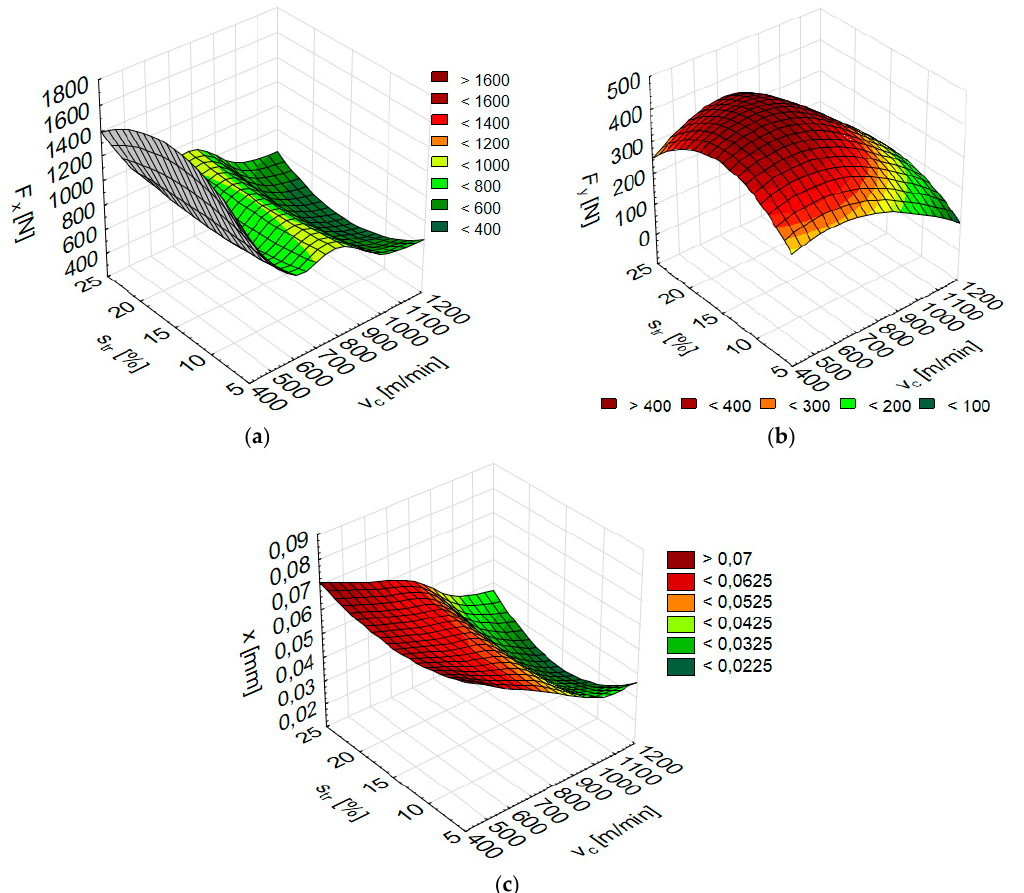
Figure 12. Numerical results of ( a ) Fx, ( b ) F y and ( c ) x depending on the cutting speed v c and trochoidal step s tr for AZ31 alloy (F x : RBF 2-5-1, F y : RBF 2-6-1, x: RBF 2-7-1).